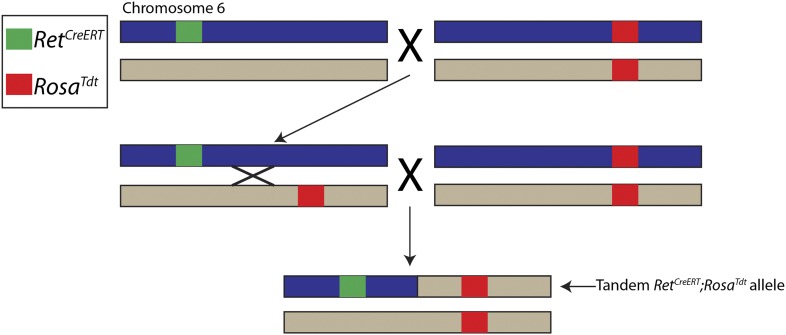
Generation of tandem RetCreERT;RosaTdt allele.The Ret and Rosa loci are located ∼5 megabases apart on mouse chromosome 6. RetCreERT/+ mice were crossed to RosaTdt/Tdt mice to generate RetCreERT/+;RosaTdt/+ mice, which were crossed back to RosaTdt/Tdt mice. Occasionally, an interchromosomal recombination event occurred between the Ret and Rosa loci, which caused RetCreERT and RosaTdt to be located on the same chromosome. Recombinants were identified by genotyping for the RetCreERT allele and the homozygous presence of the RosaTdt allele. The chromosome containing both RetCreERT and RosaTdt alleles is called the tandem RetCreERT;RosaTdt allele and maintained by mating with RosaTdt/Tdt mice.